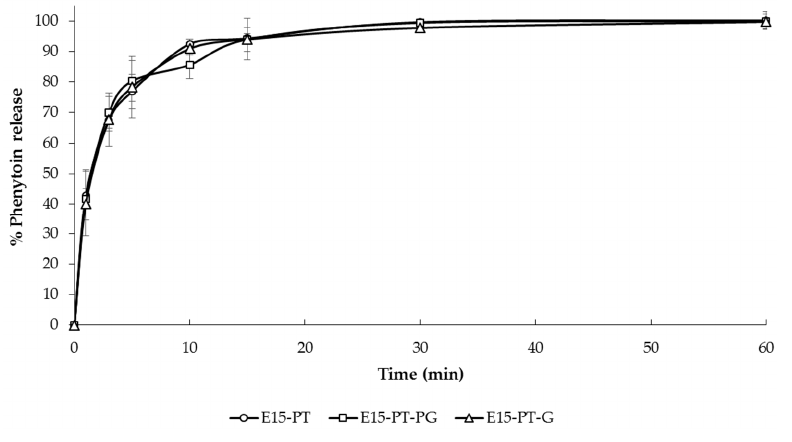
Figure 5. In vitro phenytoin release from E15-PT, E15-PT-G and E15-PT-PG 3D-printed ODFs ( n = 3) in Tris with 1% w/v SLS buffer solution (pH 6.8).